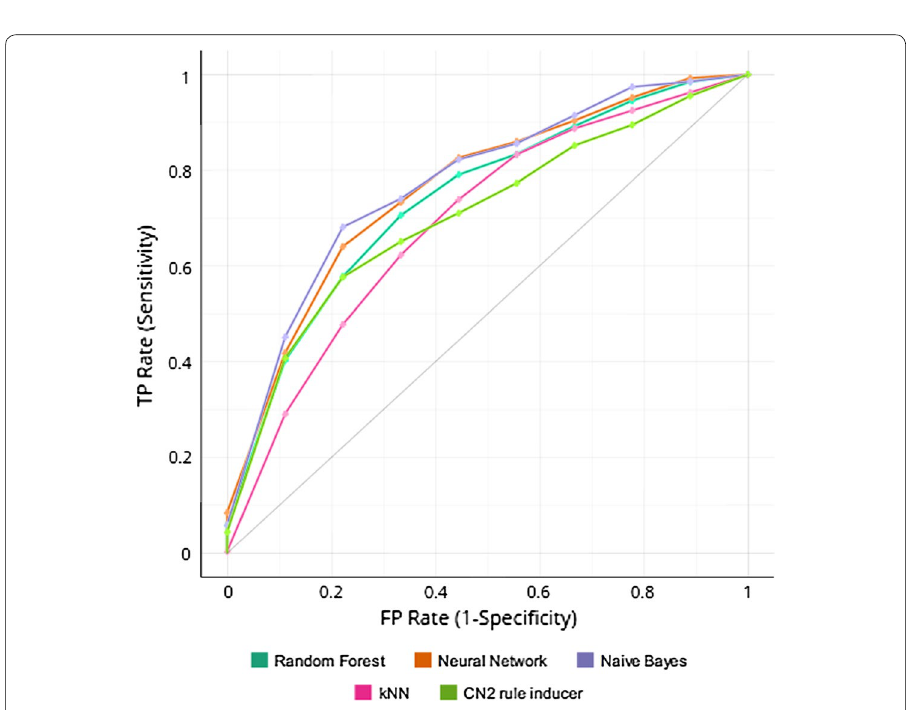
Fig. 12 ROC for the SDT IP download